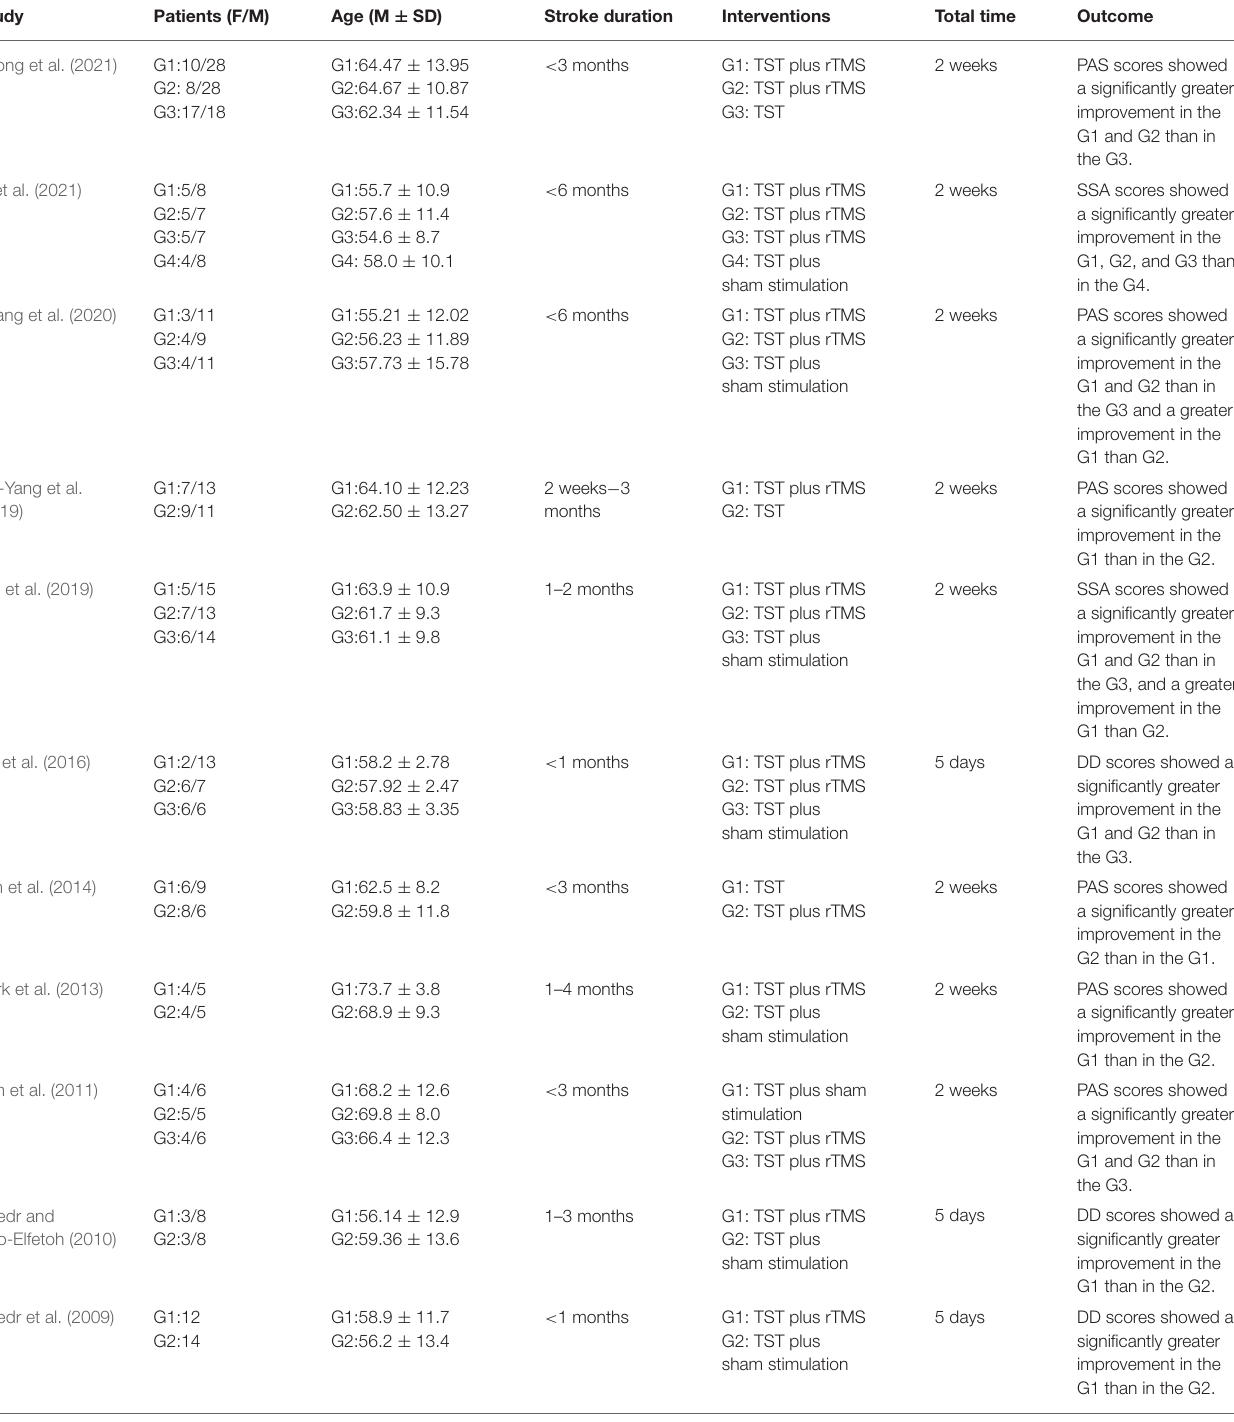
TABLE 2 | The detailed features of the studies. Study Patients (F/M) Age (M ± SD) Stroke duration Interventions Total time